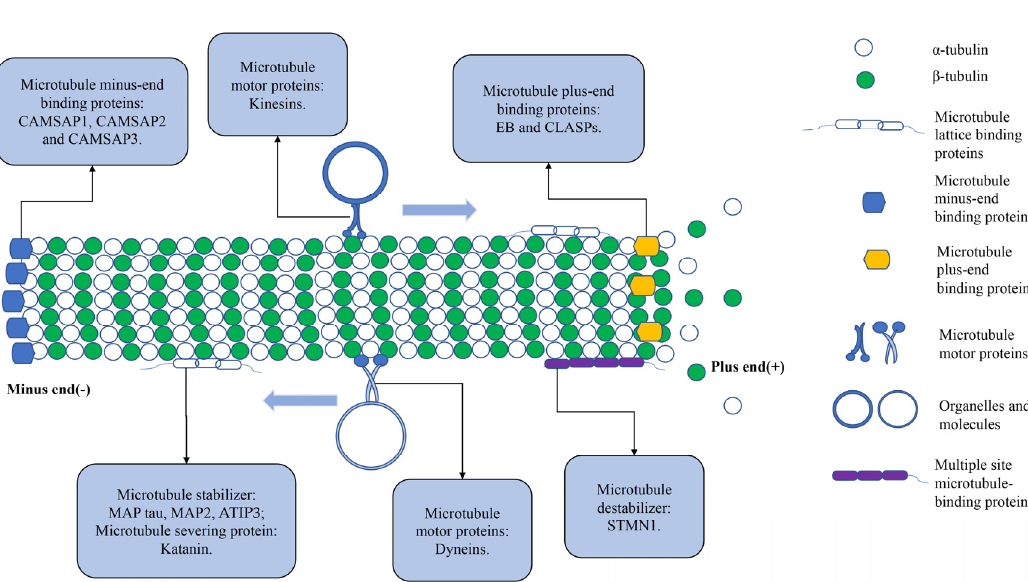
Figure 2. Schematic representation of microtubule − associated protein (MAP) binding to microtubules at different sites. The main proteins include microtubule crystal − binding proteins (MAP tau, MAP2, ATIP3, and katanin), microtubule movement proteins in which kinesins carry organelles or molecules to the plus − end of microtubules (anterograde transport); dyneins that transport cellular molecules to the minus − end of microtubules (retrograde transport); multisite microtubule − binding protein stathmin (STMN1); microtubule plus − end − binding proteins (EB and CLASPs); and microtubule minus − end-binding proteins (CAMSAP1, CAMSAP2 and CAMSAP3).